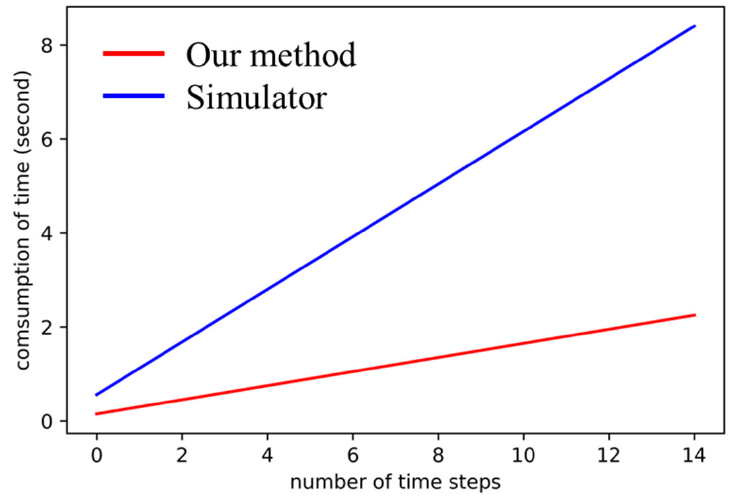
Figure 19. The contrast for predicting results from our method and labels by the simulator.